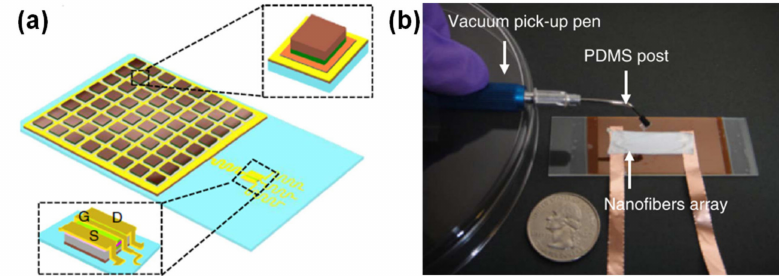
Figure 5. Piezoelectric e-skin sensors, developed by ( a ) John Rogers and co-workers in 2014 [90] (Copyright © 2020, Springer Nature) and ( b ) John Rogers and co-workers in 2013 [104] (Copyright © 2020, Springer